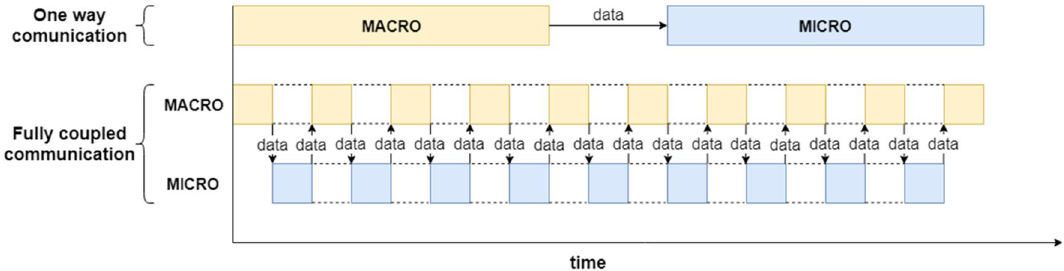
Fig. 1 Diagram showing differences between a one-way and a fully coupled approaches in a multiscale